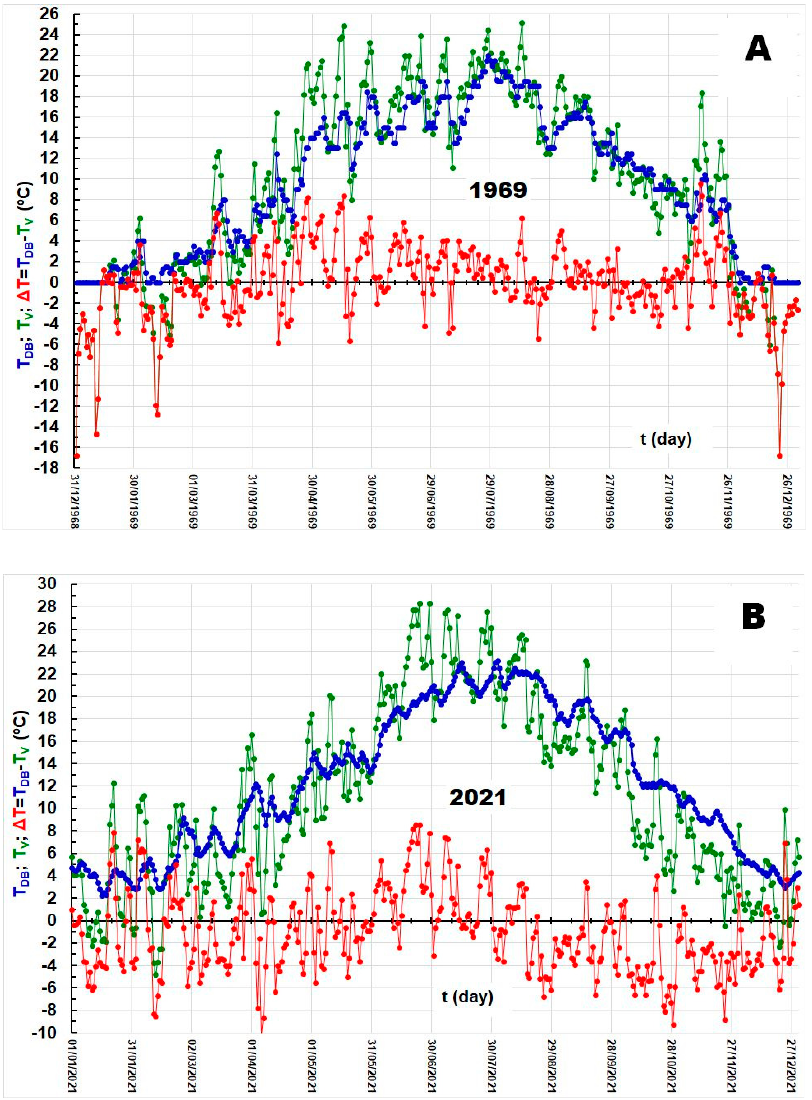
Figure 11. Series of daily water temperatures of the Drava at Botovo station (blue color), T DB , average daily air temperatures at Varaždin (green color), T V , and their differences (red color), ∆ T = T DB − T V , during 1969 ( A ) and 2021 ( B ).